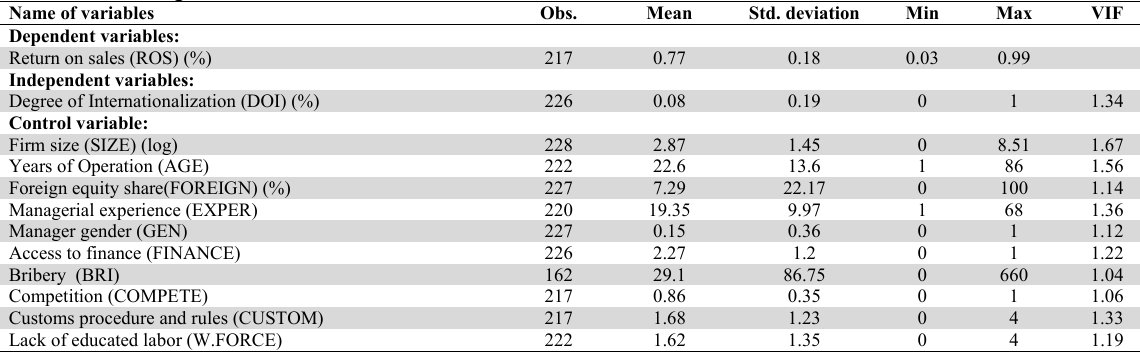
Statistics describing variables in the research